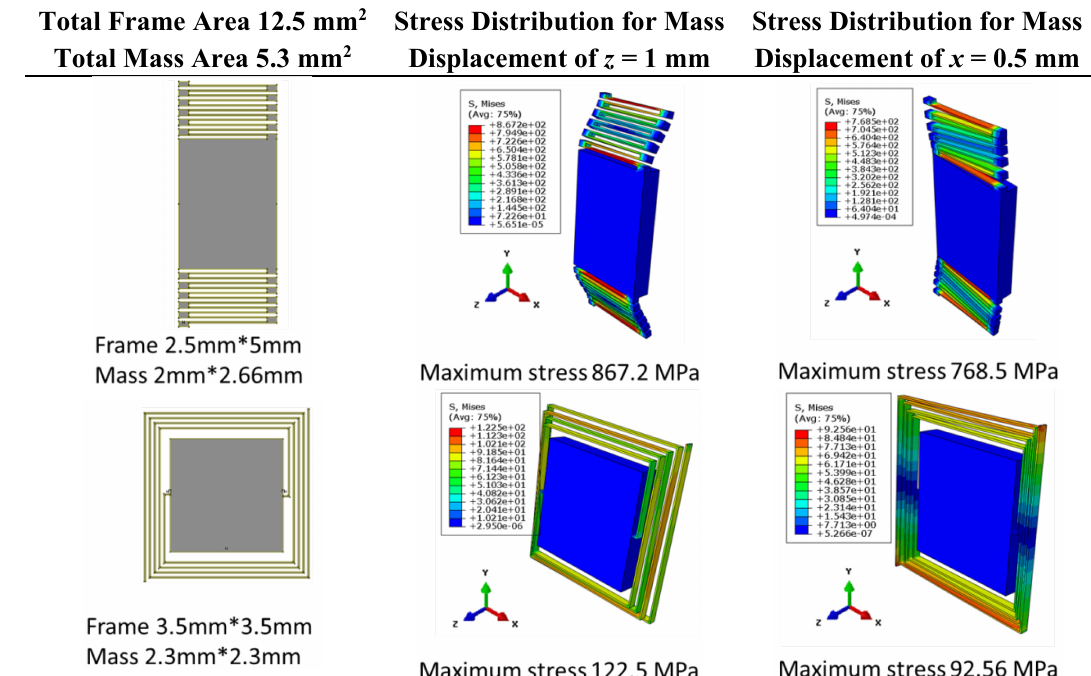
Table 3. Stress analysis for folded and spiral spring